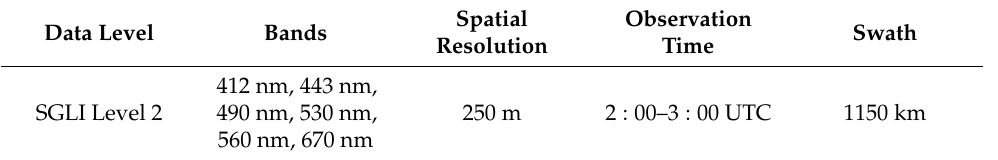
Table 2. Main parameters of SGLI L2 in visible bands provided by the satellite GCOM-C. Data